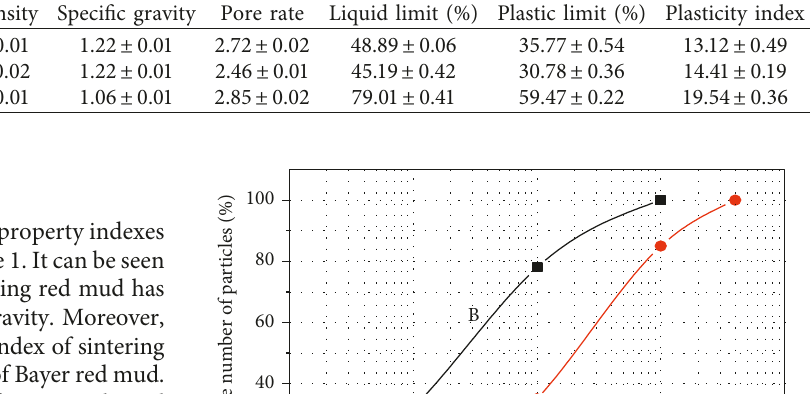
Table 1: Basic physical parameters of three kinds of red mud. Type of sample